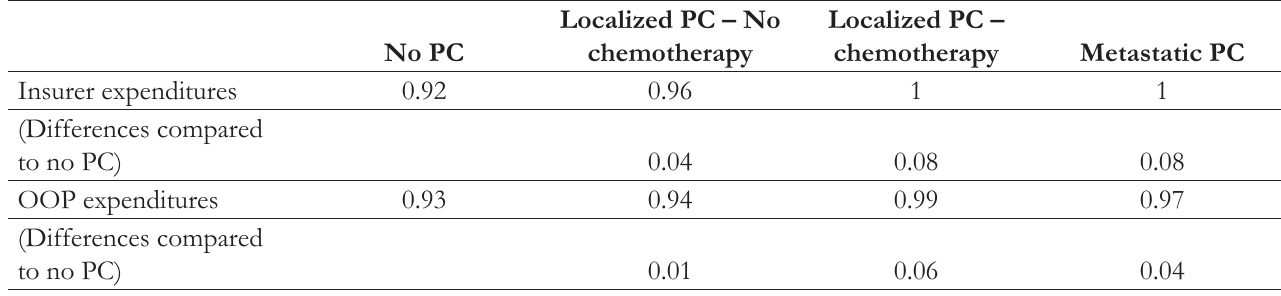
Table 3. Effects of PC on Predicted Probability of Incurring Expenditures [per annum]